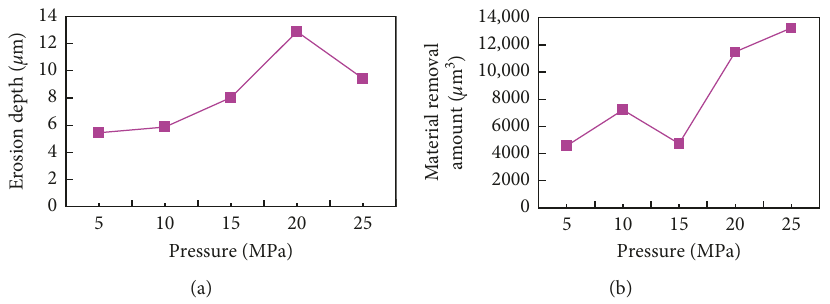
Figure 8: The influence of waterjet pressure on (a) erosion depth and (b) material removal amount.